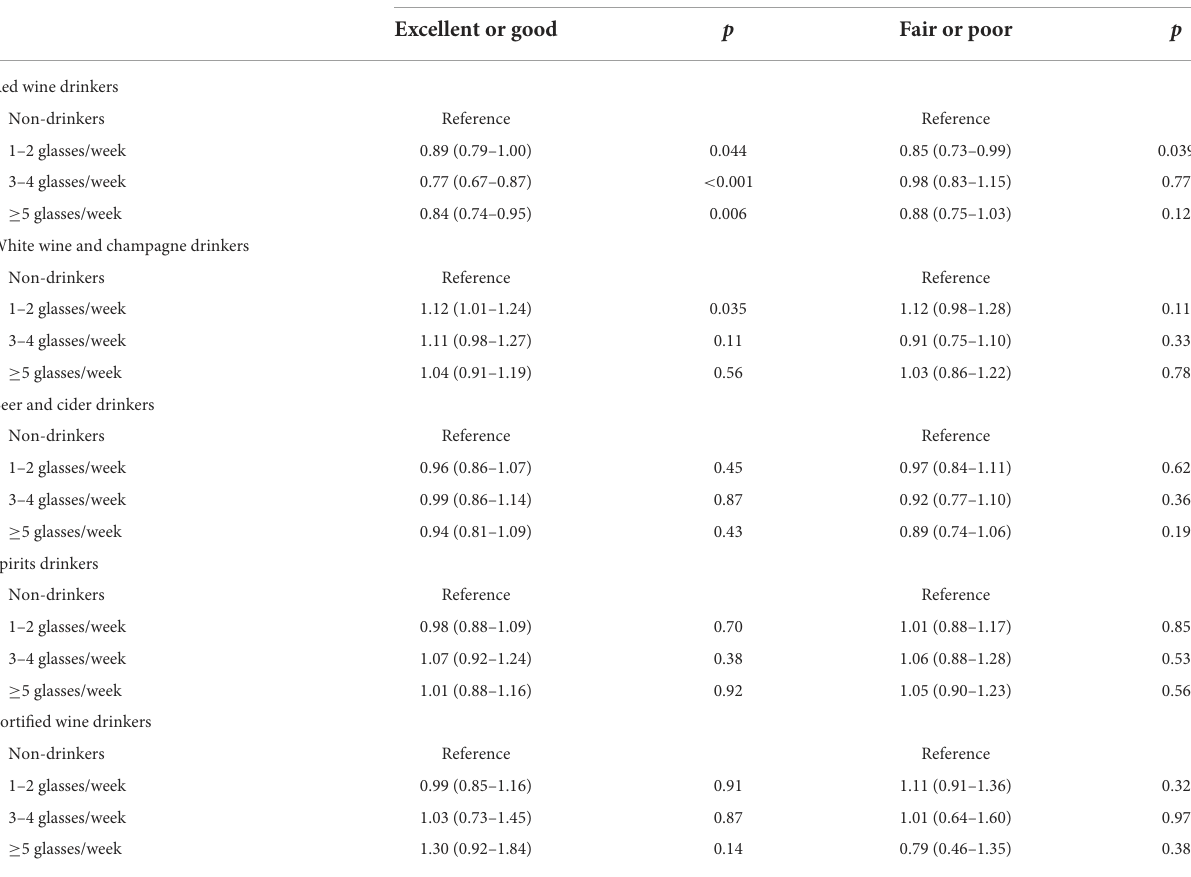
TABLE 6 Odds ratios and 95% CIs for the association between different alcoholic beverages and IBD risk, separated by overall health rating.